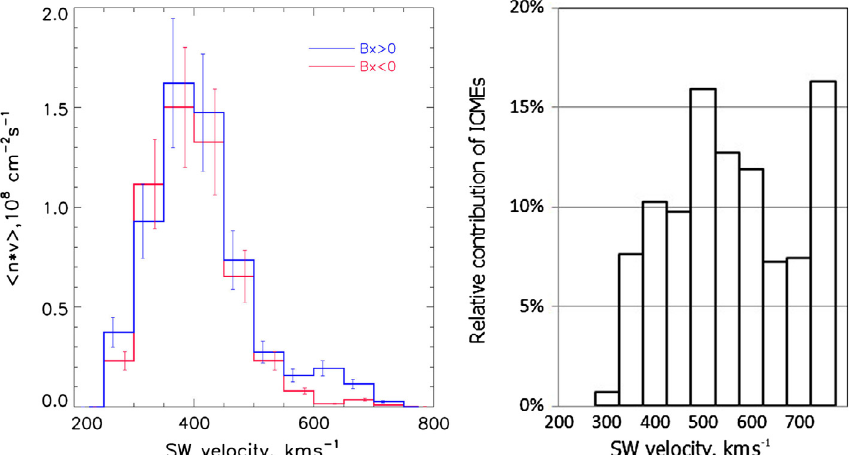
Figure 6. Left: variation of the mean SW density flux averaged over 2012 versus the SW velocity. The SW density flux with the positive polarity Bx -component of the IMF is marked by the blue line, and that with negative polarity is marked by the red line. Right: relative contribution of ICME (in %) to the SW flux in 2012 as function of SW speed.